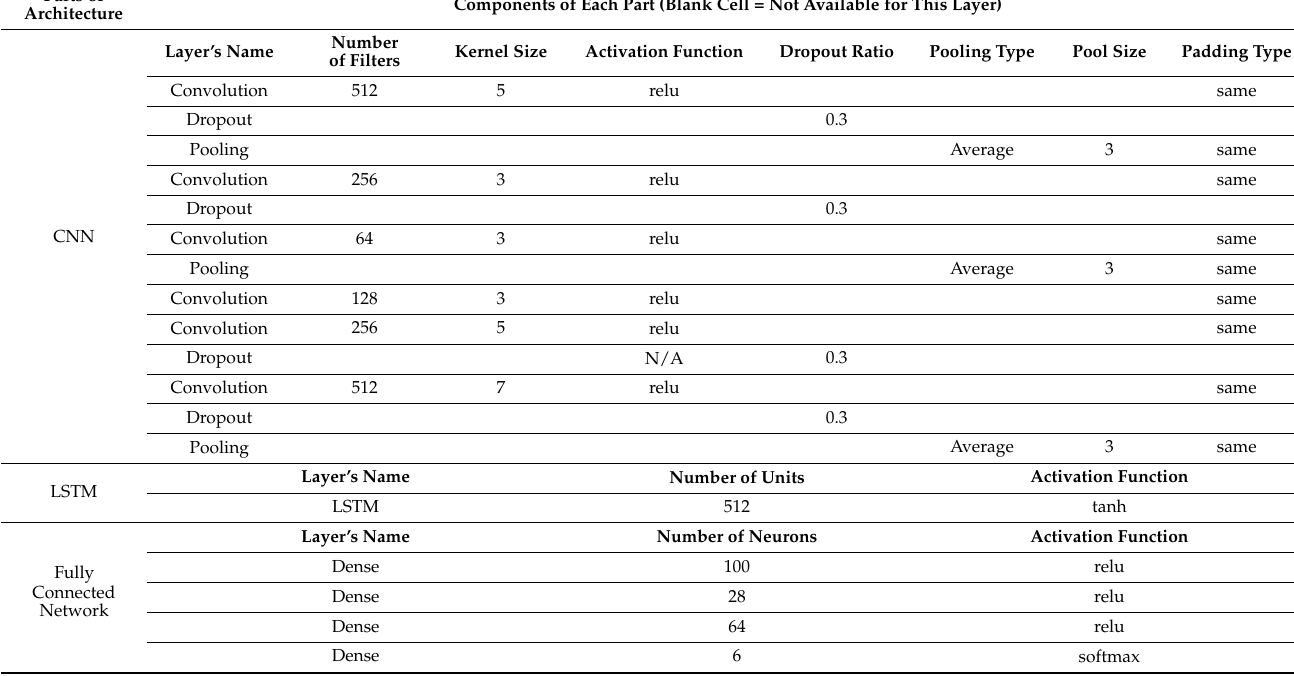
Table 4. A detailed description of our proposed 1D-CNN-LSTM